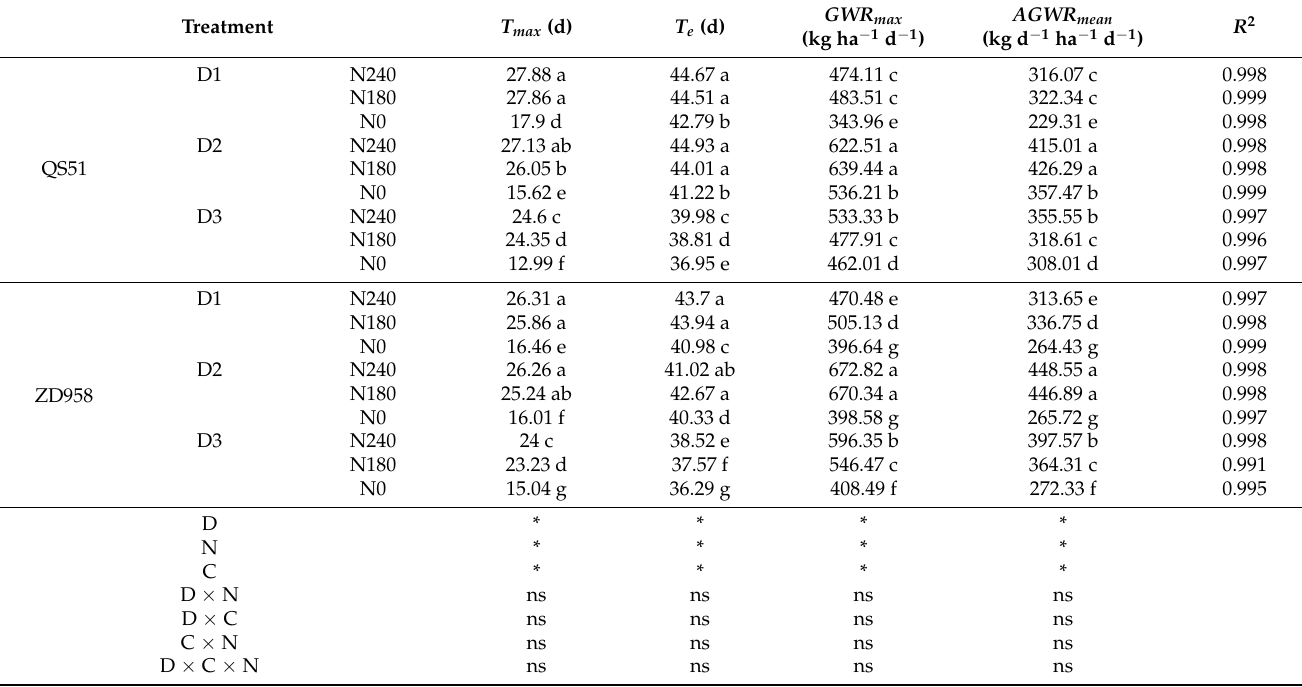
Table 2. Analysis of variance of maize grain weight characteristics parameters at different planting densities and nitrogen rates for QS51 and